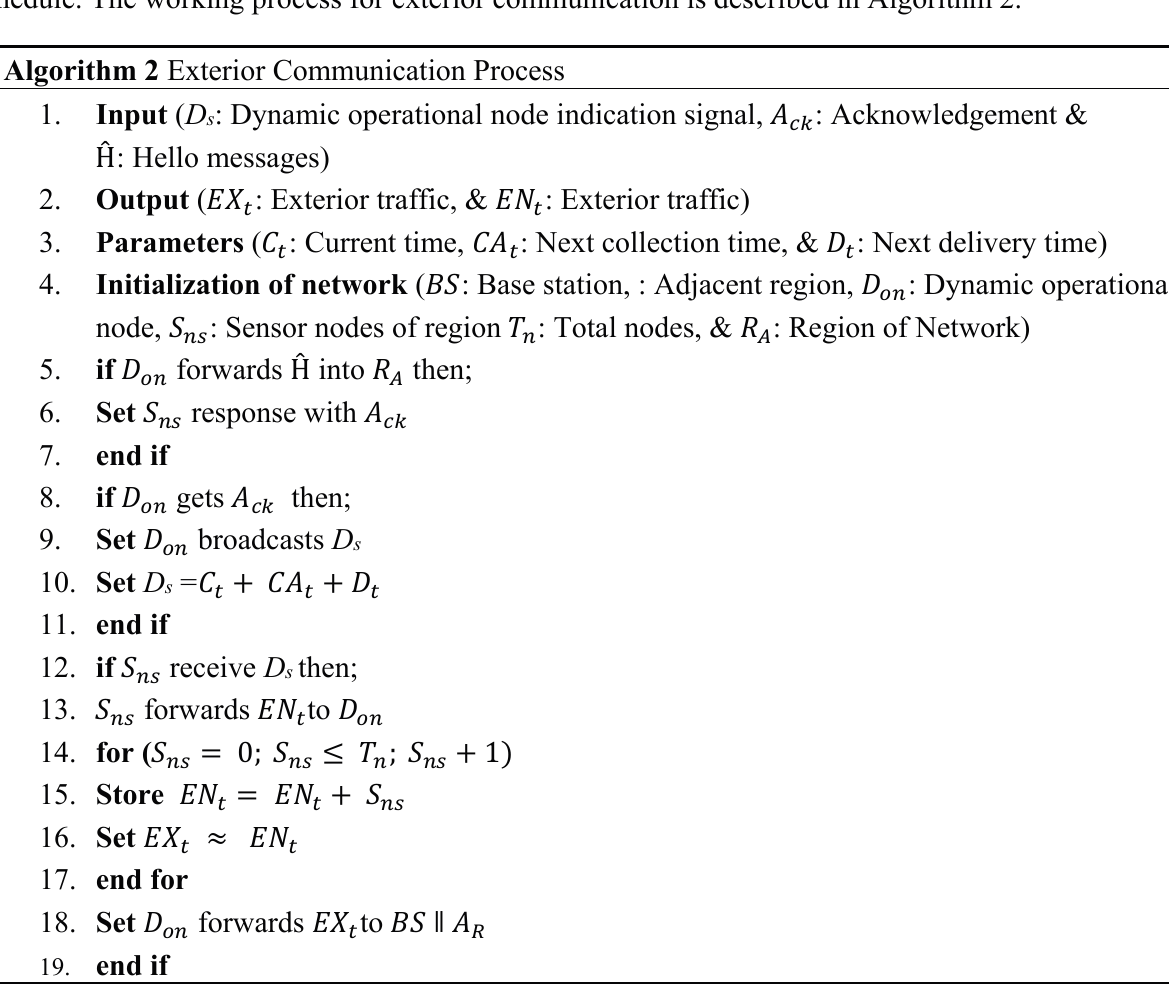
Algorithm 2 Exterior Communication